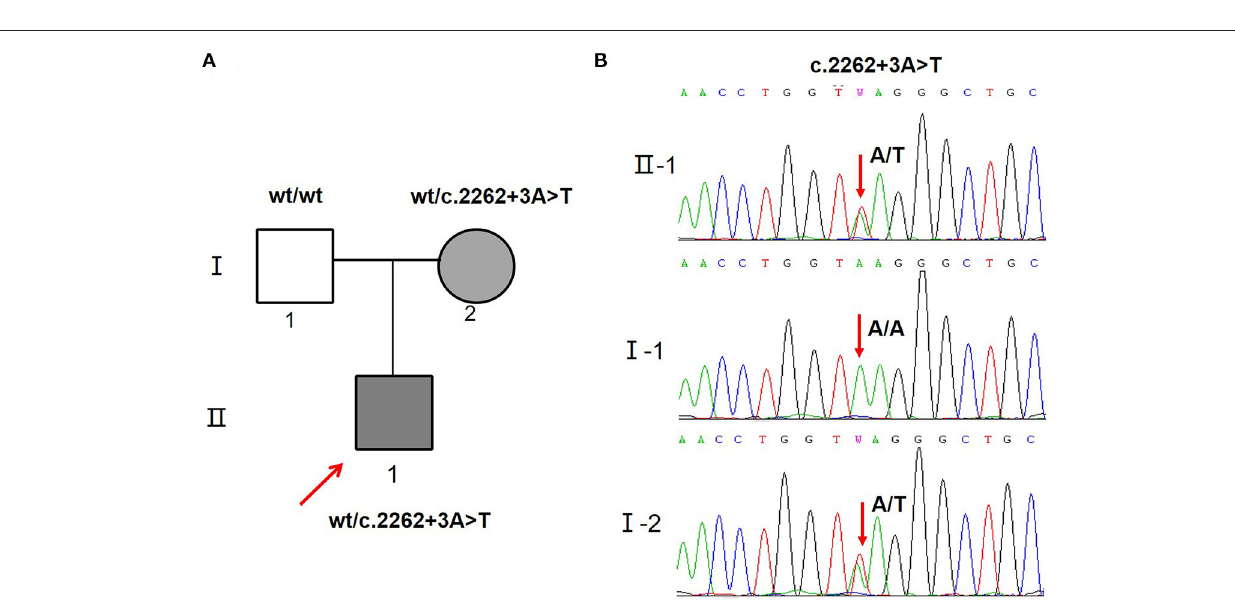
FIGURE 2 | SCN5A gene variants identified in the proband and his family. (A) Schematic presentation of the familial pedigrees. Males and females are designated by squares and circles, respectively. The shapes filled with shadow indicate affected individuals with SCN5A mutation, arrow indicates proband. (B) Direct sequencing showing the novel variant c.2262 + 3A > T of the SCN5A